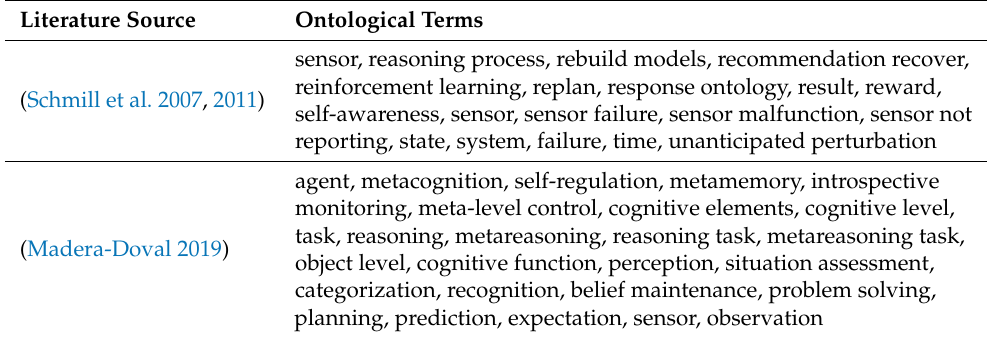
Table 1. Literature sources for ontology knowledge and terms used in existing ontologies related to metareasoning.